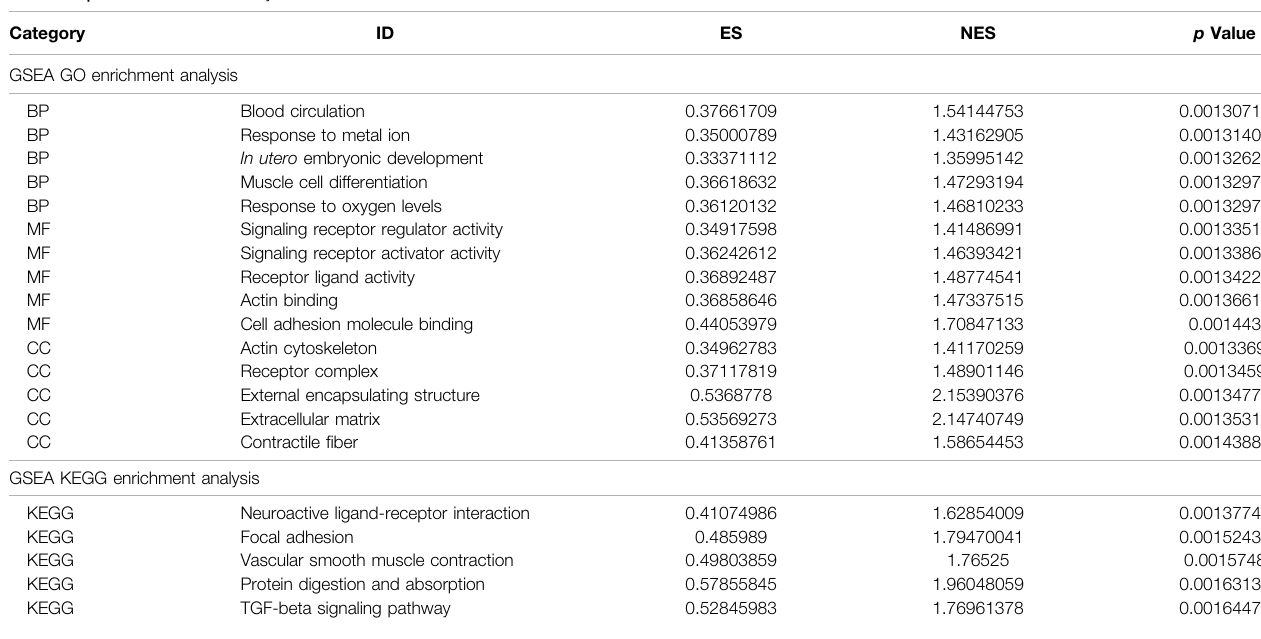
TABLE 3 | GSEA enrichment